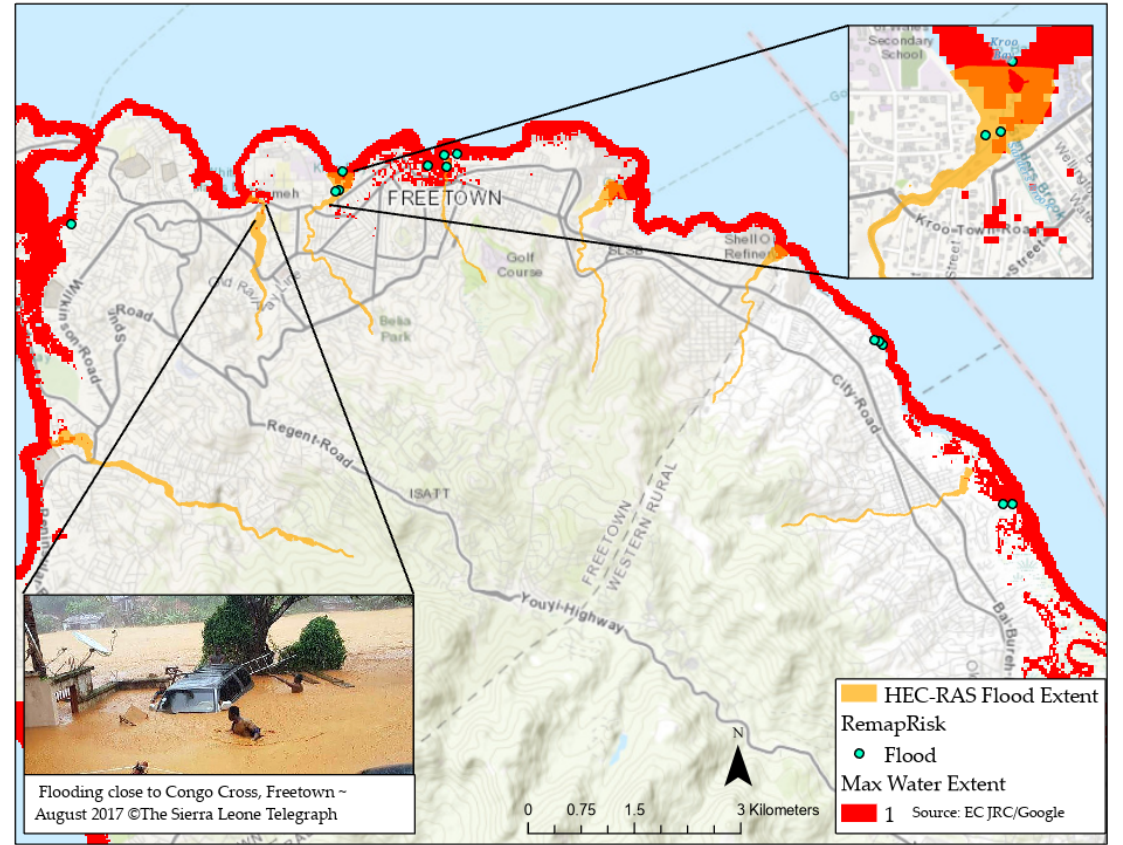
Figure 5. HEC-RAS modeled flood extents compared to historic flood event points and maximum water extent .